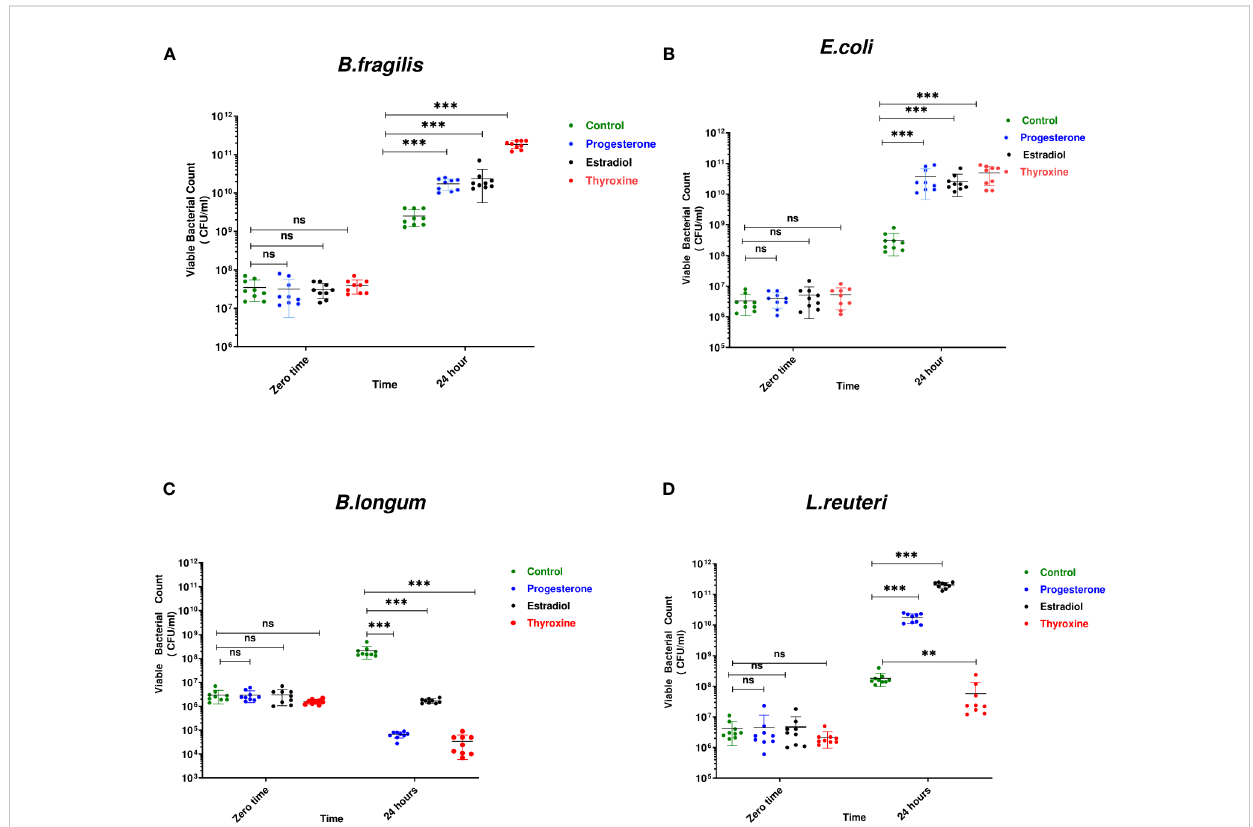
FIGURE 1 Growth of bacteria under the effect of hormonal drugs. Effect of hormonal drugs on the growth of: Gram-negative bacteria (A) Bacteroid fragilis , (B) Escherichia coli , and Gram-positive bacteria (C) Bi fi dobacterium longum , (D) Limosilactobacillus reuteri represented as viable count (CFU/ml). Tested hormonal drugs include progesterone, ethinyl estradiol, and L-thyroxine in their intestinal concentrations, 211.99, 0.562, and 0.0481µM, respectively. Control represents the growth of bacteria in addition to DMSO. Mann-Whitney t-test was used to statistically compare the effect on bacterial growth. Signi fi cance level of **(P<0.001), ***(P<0.0001). ns, non signi fi